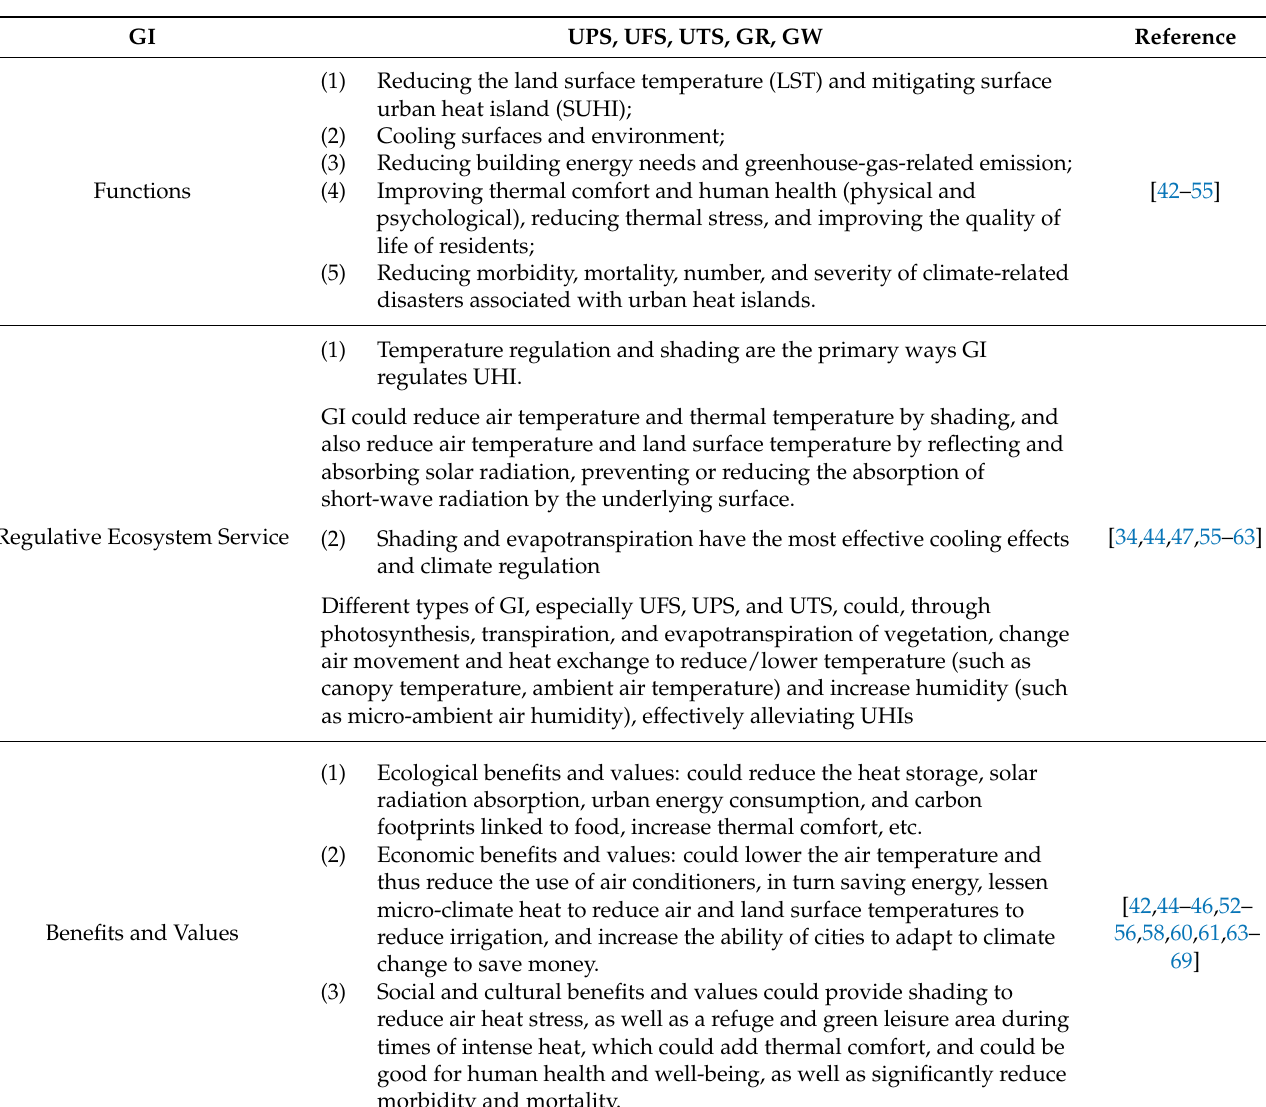
Table 6. The functions and regulative ecosystem services, benefits, and values of